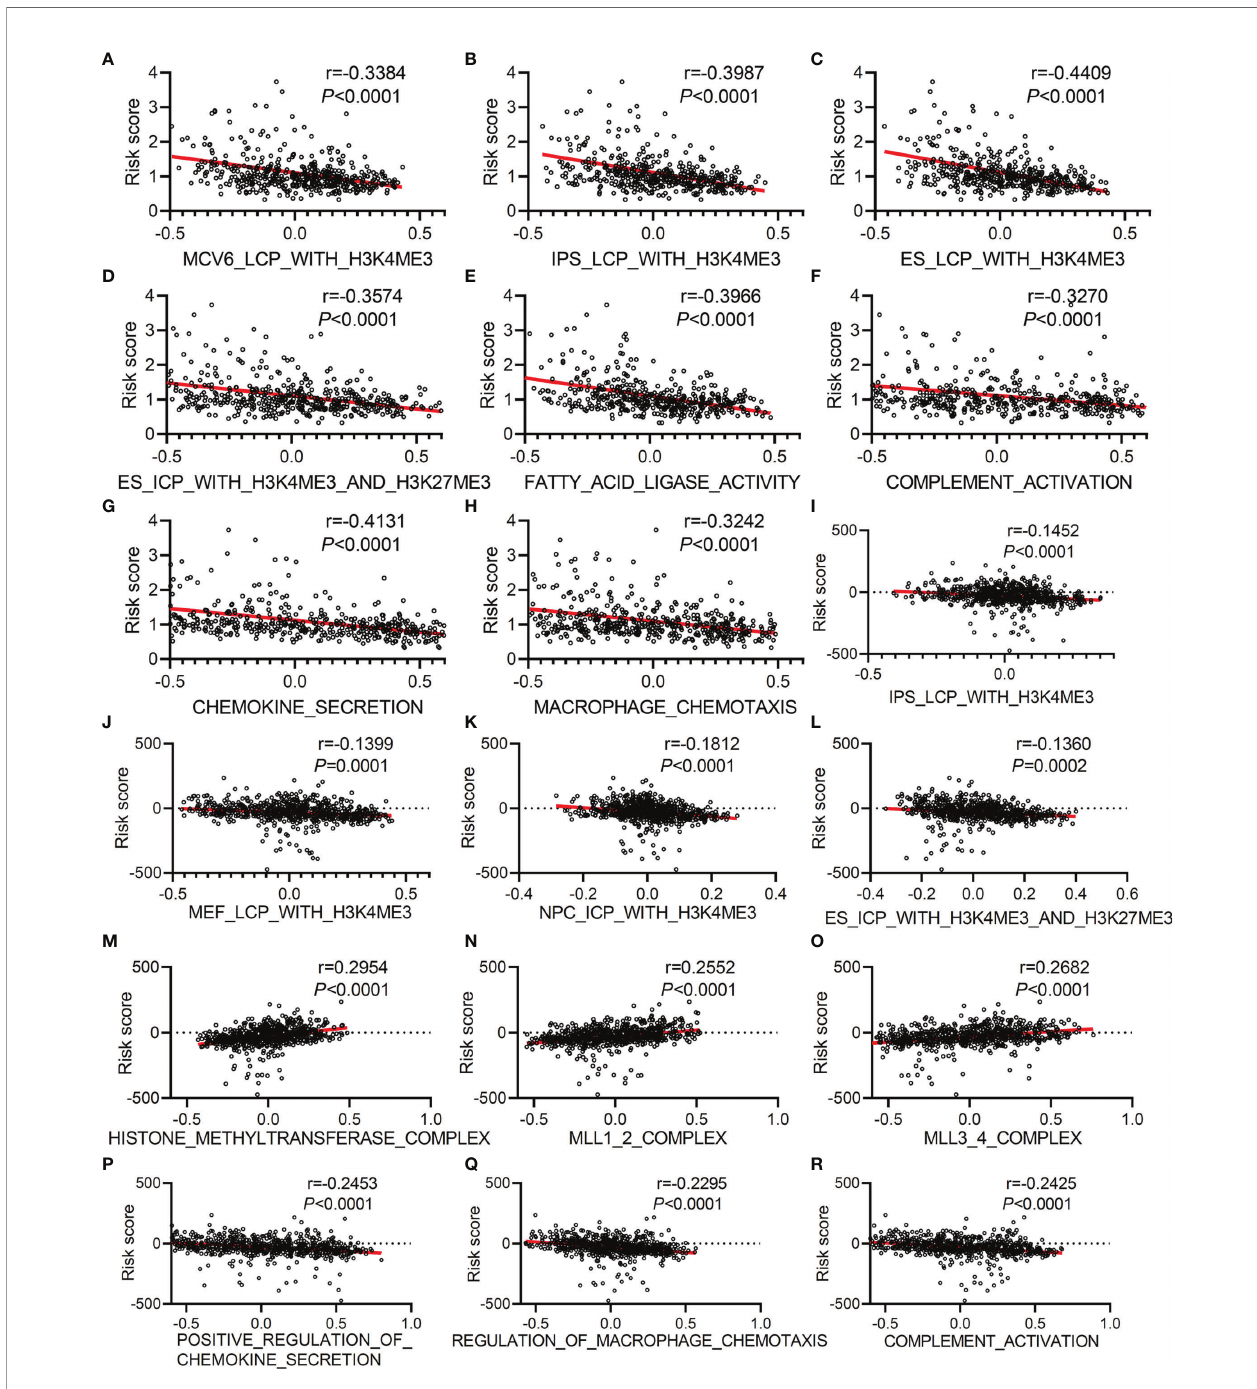
FIGURE 6 | The correlation analysis between risk score and histone trimethylation modi fi cation, immune activity, and fatty acid metabolism based on GSVA analysis of gene expression data collected from TCGA and GEO. Correlation analysis between risk score and MCV6_LCP_WITH_H3K4ME3 (A) , IPS_LCP_WITH_H3K4ME3 (B)